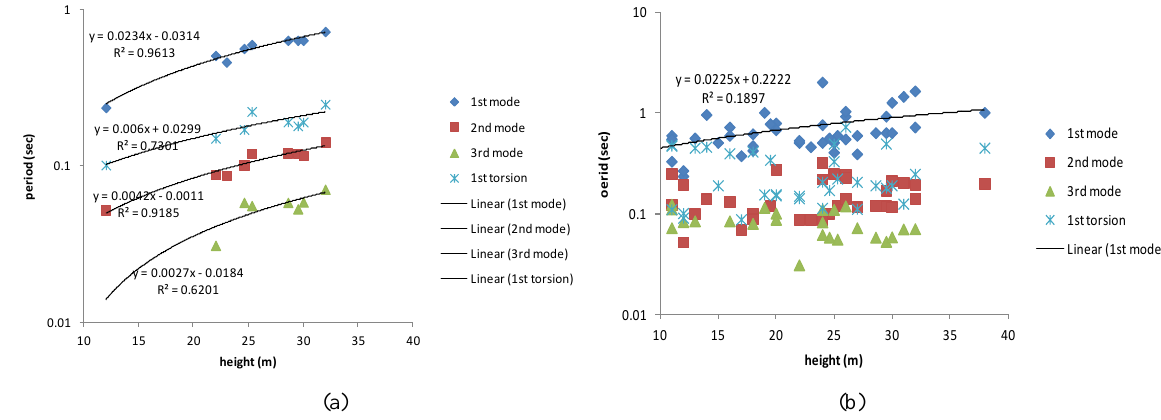
Fig. 3. Correlation of vibration period (y) with tank height (x) for different modes: a) Hintze type 1a ; b) all